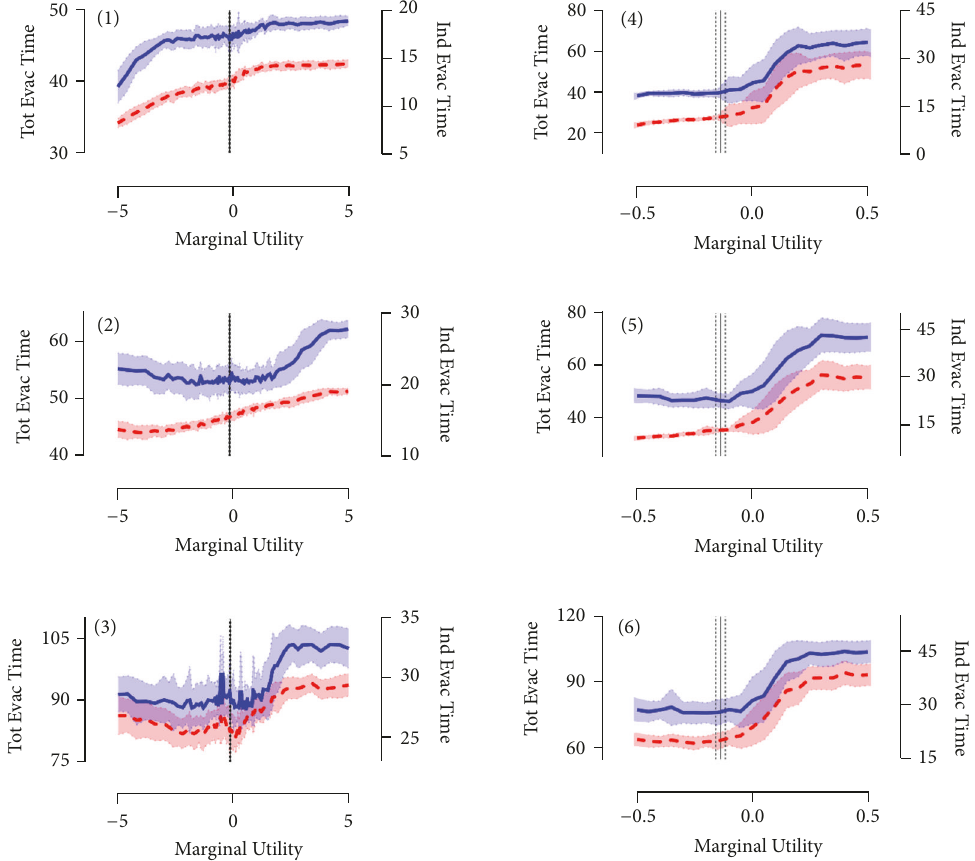
Figure 9: Variations of the simulated total evacuation times (blue solid lines; left vertical axis) and simulated average individual evacuation times (red dashed lines; right vertical axis) as a result of changes in the marginal utility of DIST attribute in exit decision-making of the simulatedevacuees.Errorbandsshowthestandarddeviationsofthemeasurements.Theverticalsolidlinesrepresenttheempiricallyestimated value for the marginal utility of DIST, and the vertical dashed lines visualise the 95% confidence interval of that